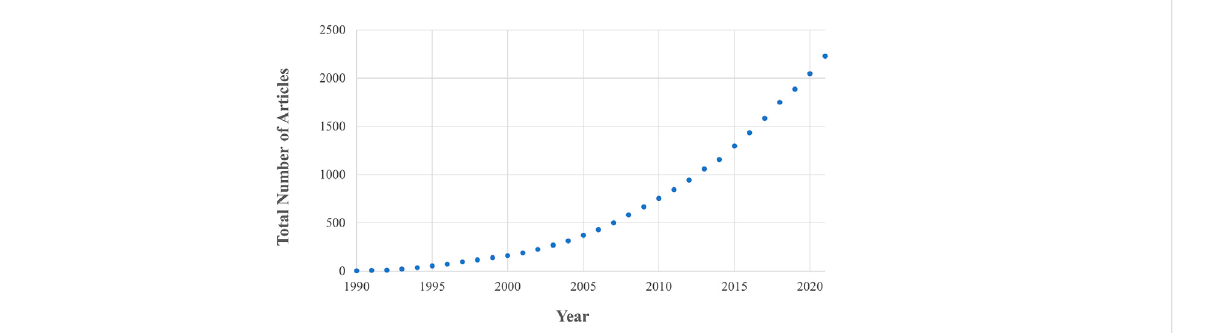
FIGURE 1 The number of in vivo animal studies published in the fi eld of implant fi xation as a function of publication year. Both the total number of articles and rate of publication is increasing. These data are the result of a Web of Science database search (17th August 2022) for: implant AND { fi xation OR cementlessORosseointegrationOR osteointegrationOR [bone AND( “ in-growth ” OR “ ingrowth ” OR “ ingrowth ” OR “ ongrowth ” OR “ on-growth ” OR “ on growth ” )]} AND (porcine OR pig OR ovine OR sheep OR murine OR mouse OR mice OR rat OR bovine OR cow OR canine OR dog OR equine OR horse OR animal) AND ( “ in vivo ” OR “ in-vivo ” ) NOT